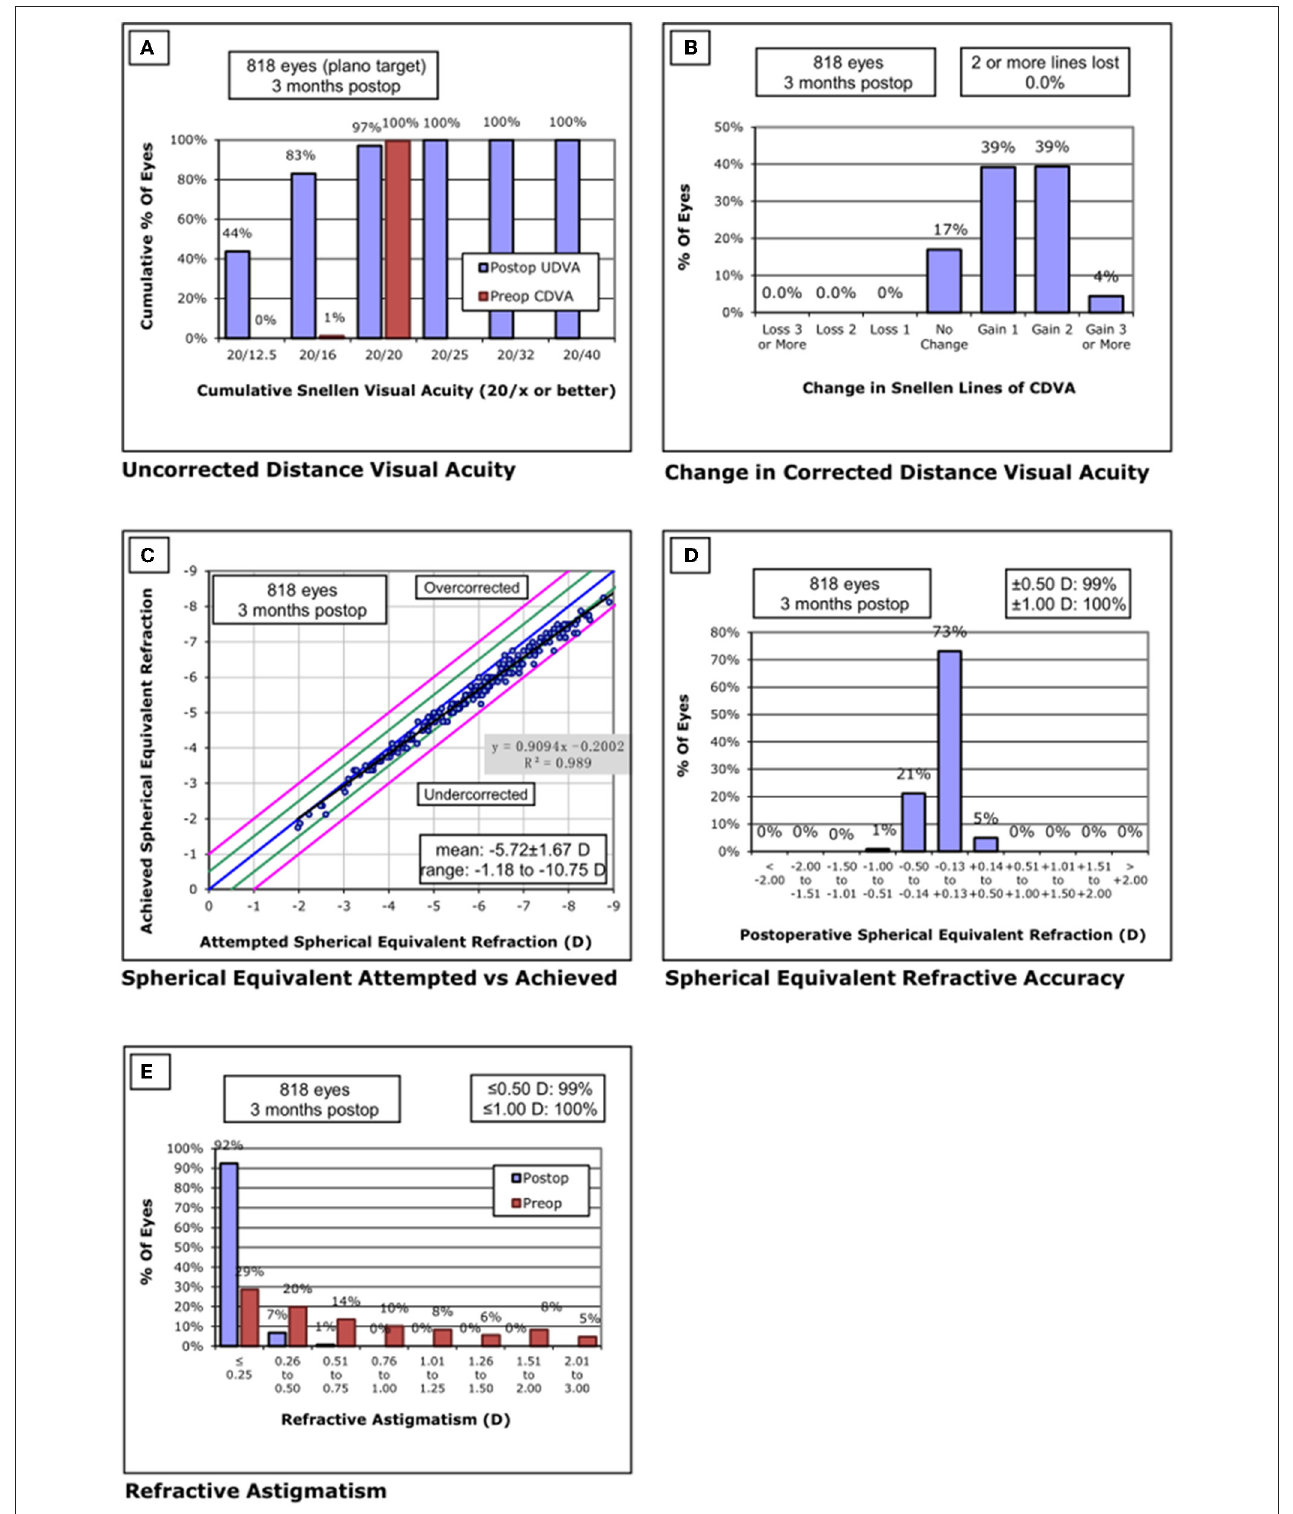
FIGURE 2 | Standard graphs of refractive surgery visual and refractive outcomes for 830 eyes at 3 months post-SMILE in center A. (A) Uncorrected distance visual acuity. (B) Change in corrected distance visual acuity. (C) Spherical equivalent attempted vs. achieved. (D) Spherical equivalent refractive accuracy. (E) Refractive astigmatism. SMILE, small-incision lenticule